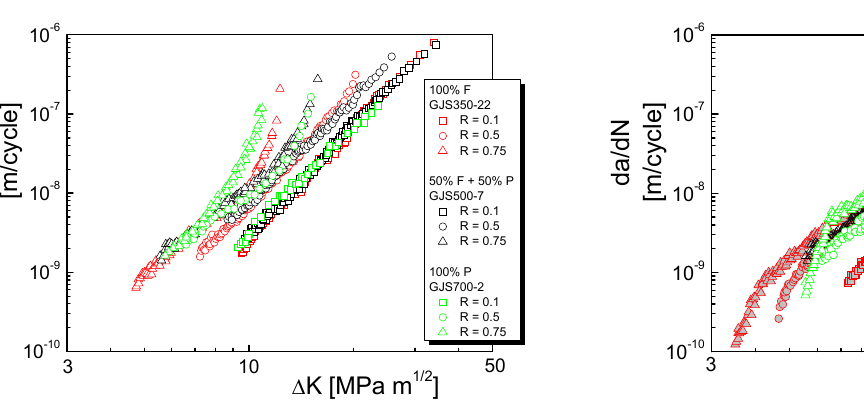
Figure 13: Stress ratio and microstructure influence on fatigue crack propagation resistance of ferritic-pearlitic DCI (obtained controlling the chemical composition).